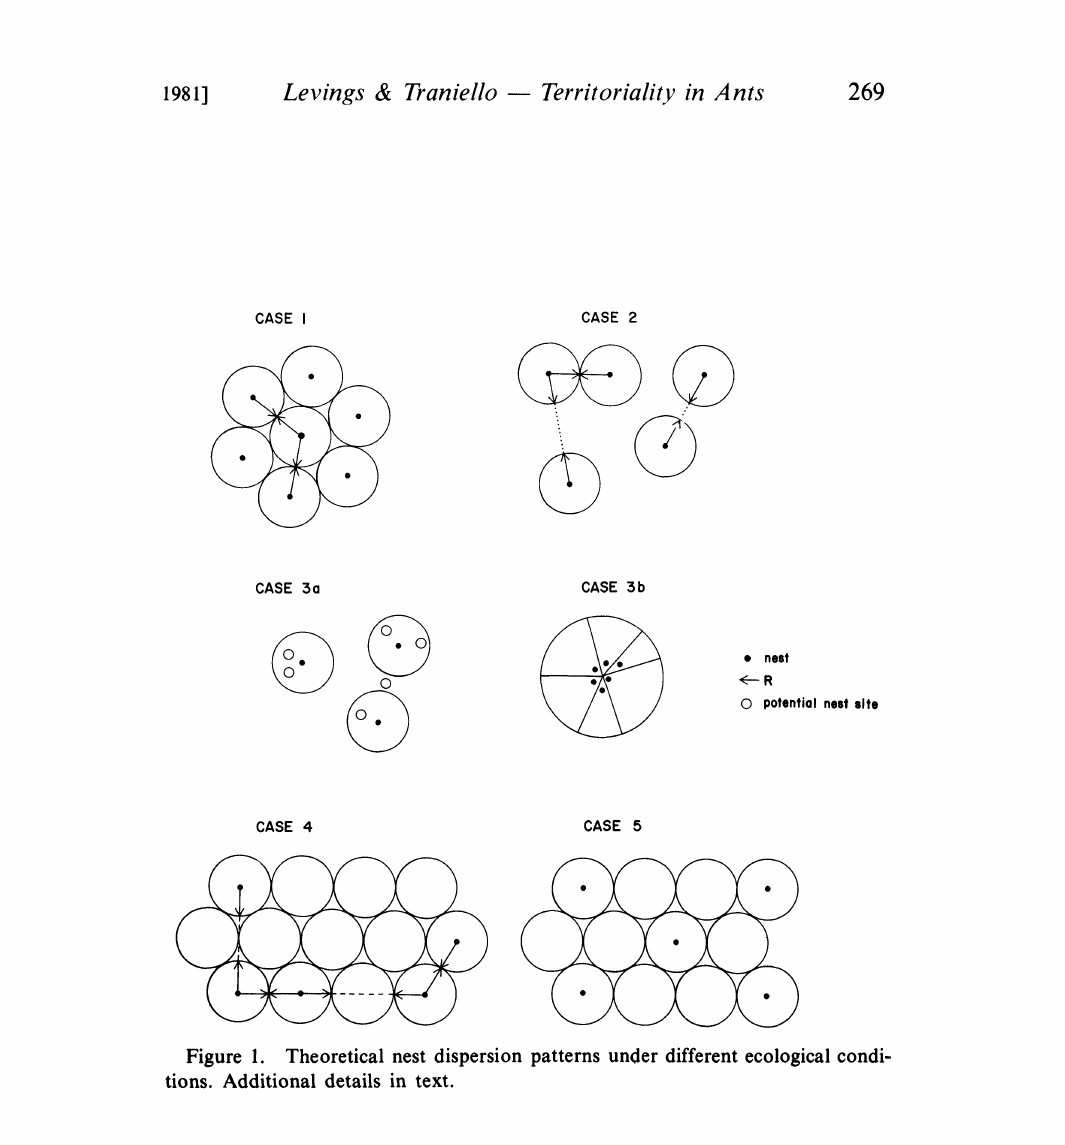
Figure 1. Theoretical nest dispersion patterns under different ecological condi- tions. Additional details in